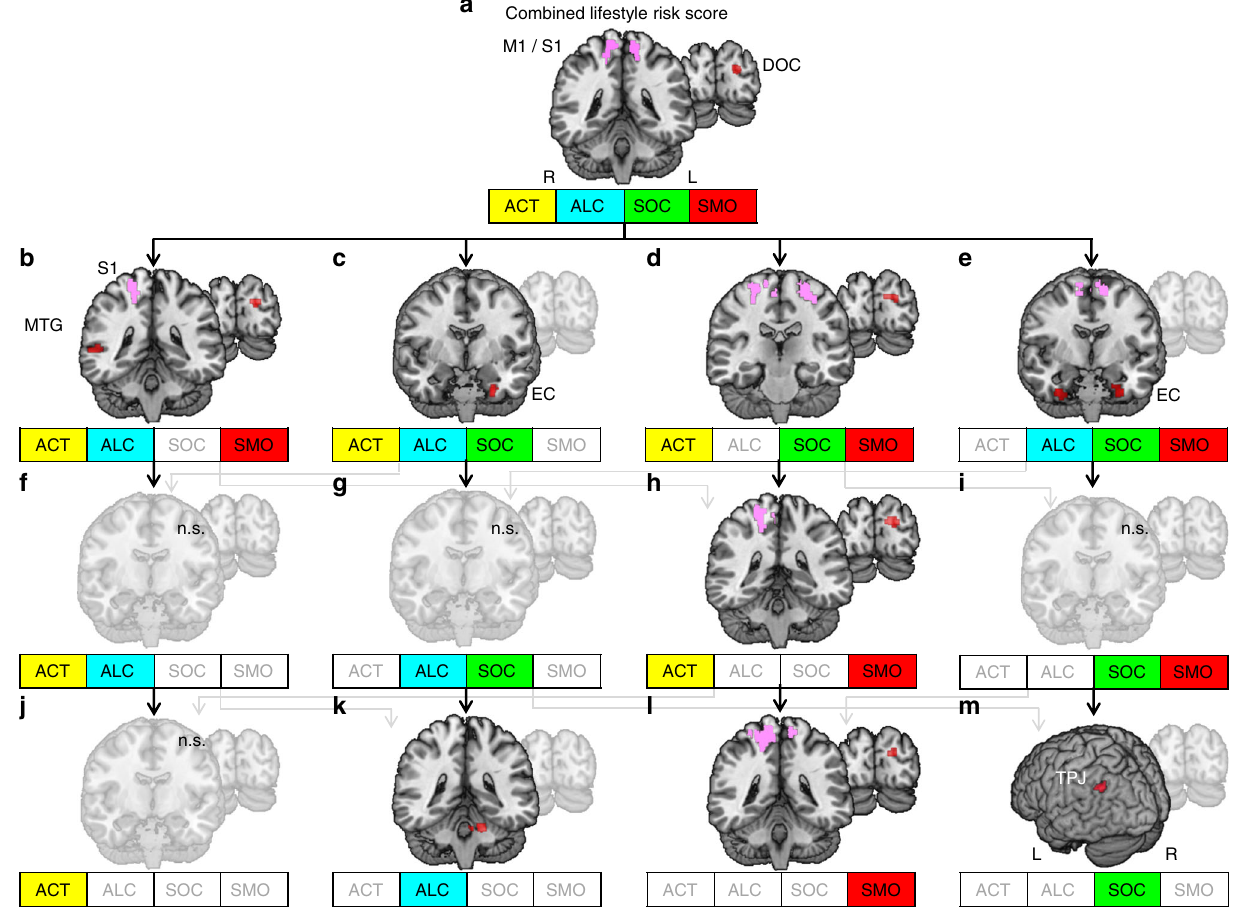
Fig. 3 Lifestyle risk-associated increases in resting-state functional connectivity (RSFC) to the seed in the left dorsal premotor cortex (dPMC). a – m Abbreviations in the small boxes refer to the same variables as in Fig. 2. Coronar sections show brain regions exhibiting increases in RSFC depicted in red. The recurrent pattern of higher RSFC between the dPMC and the somato-motor cortex is highlighted in pink. Arrows indicate the work fl ow of the stepwise exclusion. Transparent sections represent not signi fi cant (n.s.) results. This analysis included a subsample of the study population ( n = 501). Results were signi fi cant at α = 0.05 (cluster level corrected, cluster-forming threshold α = 0.001). S1 = primary somatosensory cortex, MTG = middle temporal gyrus, M1 = primary motor cortex, DOC = dorsal occipital cortex, EC = entorhinal cortex, TPJ = temporo-parietal junction, L = left